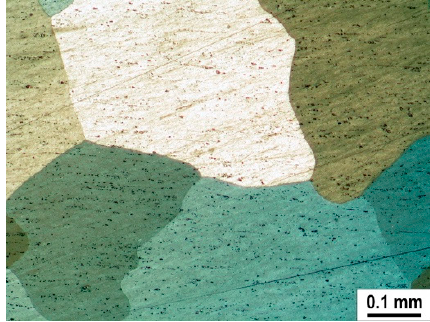
Figure 1. The microstructure of the material used (polarized light microscope).